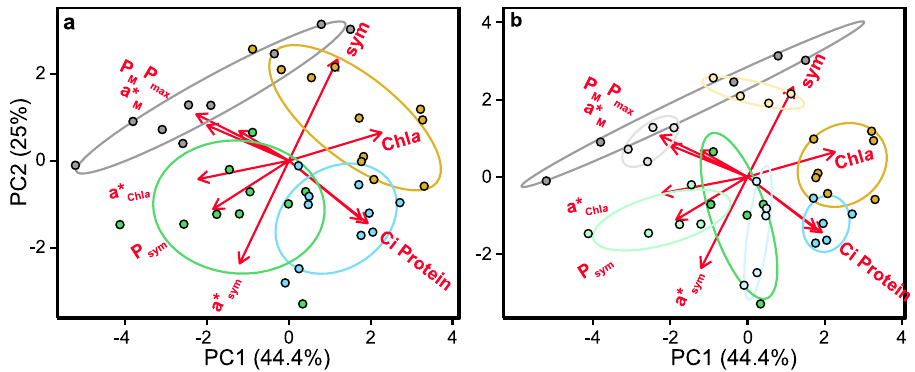
Figure 3. Principal component analysis (PCA) for the four coral species and two phenotypes investigated:. ( a ) grouping of the control specimens by species: O . annularis (grey), O . faveolata (orange), M . cavernosa (blue), and P . strigosa (green), based on the variability in their structural (Chl a , symbiont, Ci, protein content), optical (a * Chl a , a * sym , a * M ) and photo-physiological (P max , P sym , P M ) coral traits. Red arrows indicate the correlation of the different descriptors with PC1 and PC2; and ( b ) same analysis splitting each species by phenotype (summer phenotype in a lighter